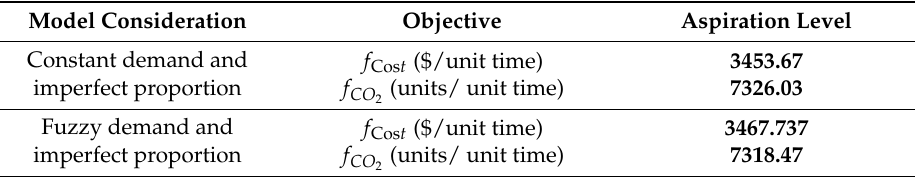
Table 2. Aspiration levels of model objectives.